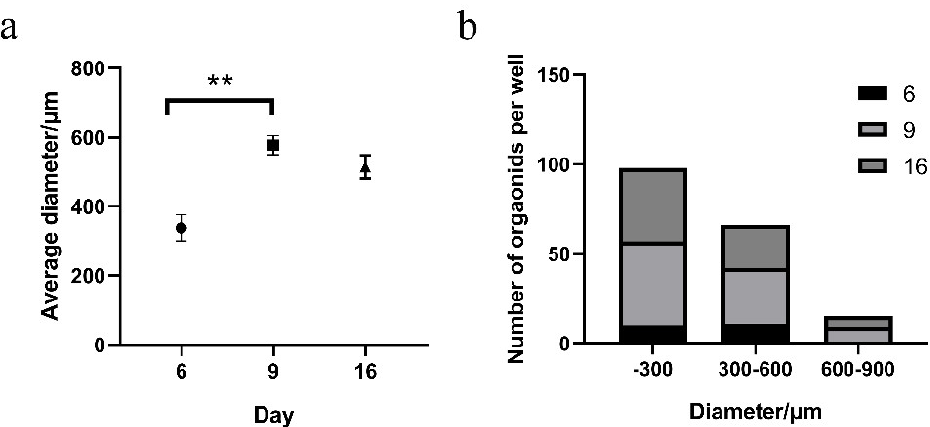
Figure 2. Particle size statistics of taste bud organoids at different growth days. ( a ) The average diameter of taste bud organoids on the 6th, 9th, and 16th day. All data represent the mean ± standard error of the mean (S.E.M.) and are shown in a histogram. ** p < 0.01 is considered as significant difference, Student’s t-test. ( b ) Different particle size distributions of taste bud organoids at different growth days.